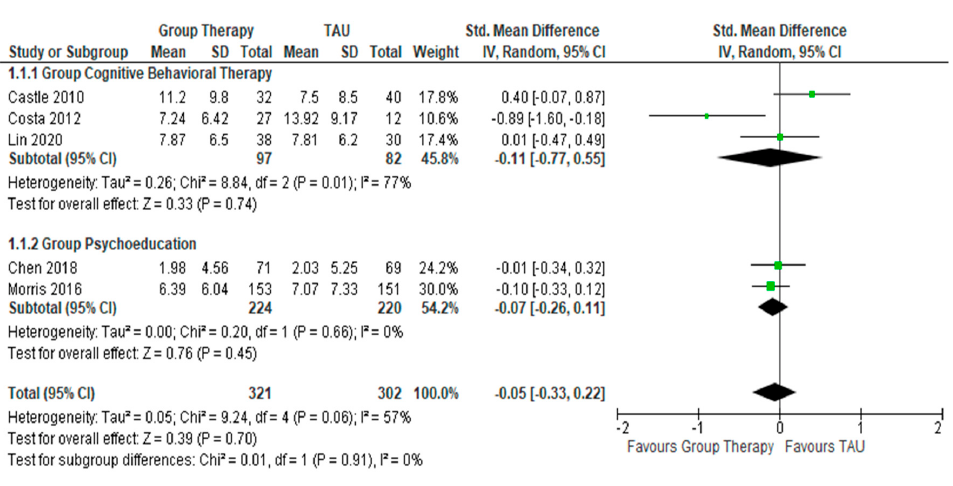
manic symptoms, which were assessed by the YMRS and Bech-Rafaelsen Mania Scale, the pooled effect size for GCBT and GPE do not indicate any significant reduction in manic symptoms as compared to control condition. For GCBT, the SMD between GCBT and the control condition is 0.24 (95% CI = − 0.08 to 0.56, Z = 1.48, p = 0.14) (I² = 10%, p = 0.33) while for GPE, the SMD between GPE and the control is − 0.04 (95% CI = − 0.23, 0.14, Z = 0.44, p = 0.66) (I² = 0%, p = 0.42). Figure 4. Forest Plots for the changes in severity of manic symptoms after interventions. 3.4. Publication Bias The funnel plots (Supplementary Figure S2a–c) for the post-intervention relapse rates, severity of depressive and manic symptoms appear symmetrical. In the funnel plot for depressive symptoms, there is an outlier whereby that study has a higher standard error as opposed to the other studies. Egger’s Regression test was calculated for relapse rates ( − 2.02, 95% CI = − 4.99 to 0.94, p = 0.15), depressive ( − 0.61, 95% CI = − 7.45 to 6.24, p = 0.79) and manic (0.82, 95% CI = − 4.28 to 5.92, p = 0.64) symptoms indicating no publication bias.